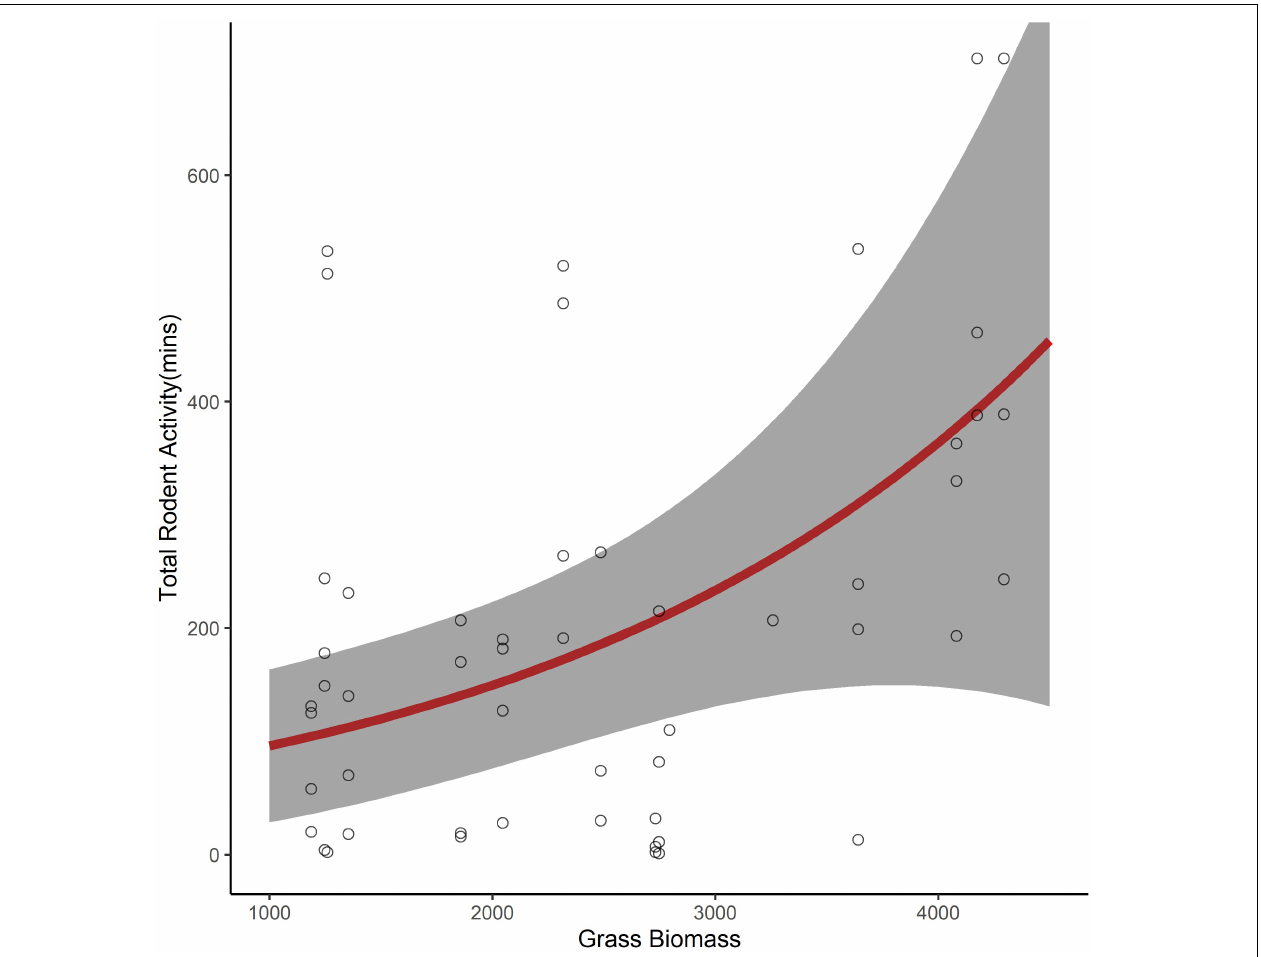
FIGURE 3 | The predicted number of minutes that rodents foraged at seed trays (95% confidence interval in gray) as a function of grass biomass (kg/ha) in the surrounding environment (0.25